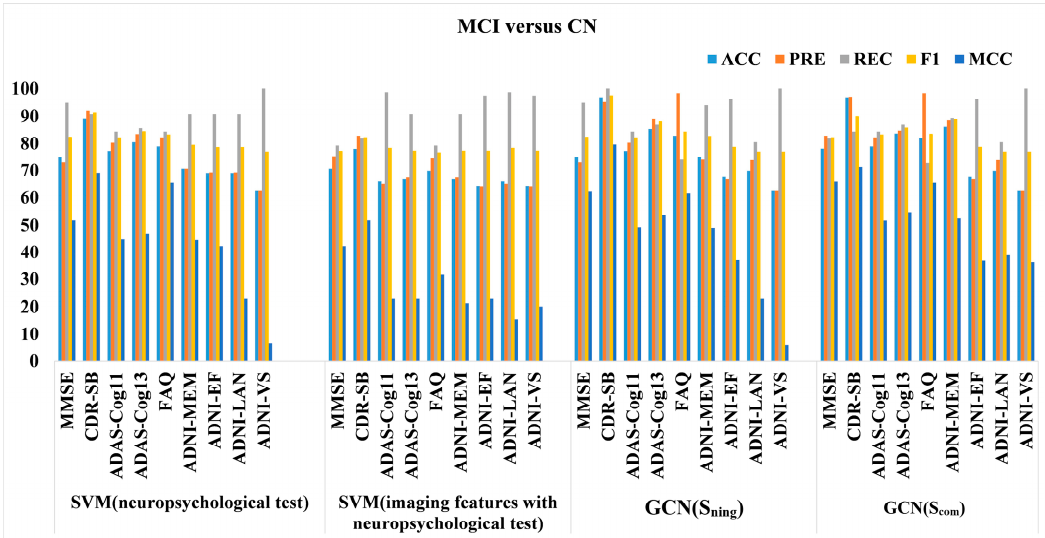
Figure 6. Performance comparison using graph features or vector features on the test data for MCI versus CN task.